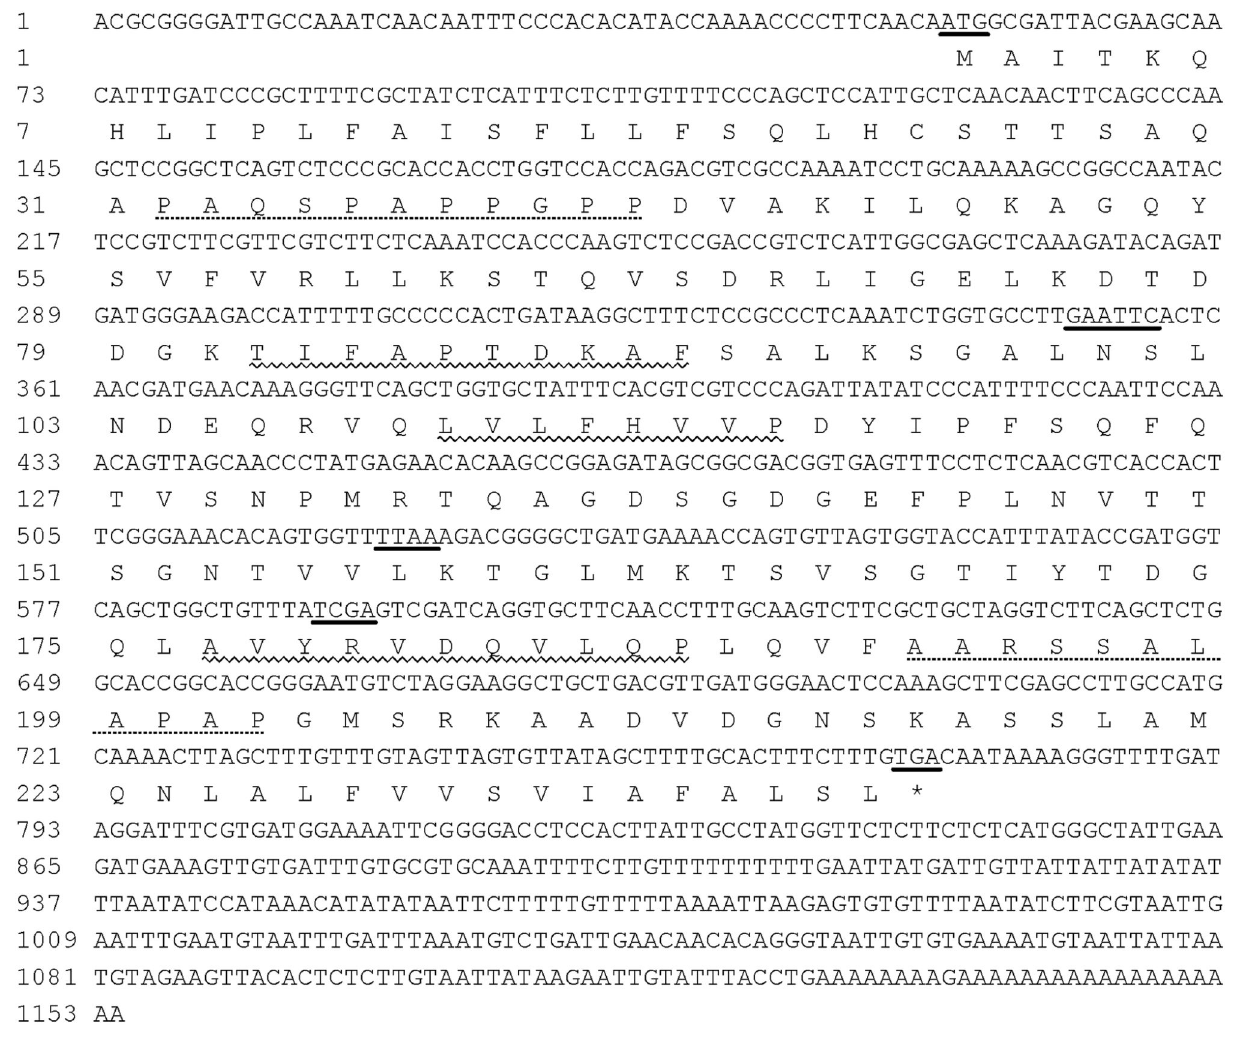
Figure 2. Full length cDNA sequence of GbFLA5 and its deduced amino acid residues. Nucleotides underlined indicate the start codon of “ATG”, the effectively restriction site in cDNA-AFLP analysis (GAATTC for Eco RI and Apo I, TTAA for Mse I and TCGA for Taq I), and the stop codon of “TGA”, respectively; three conserved regions (H1, H2 and [YA] H) of smart00554 motif were ordinal characterized by wavy line; AGP-like domains are shown by the dashed